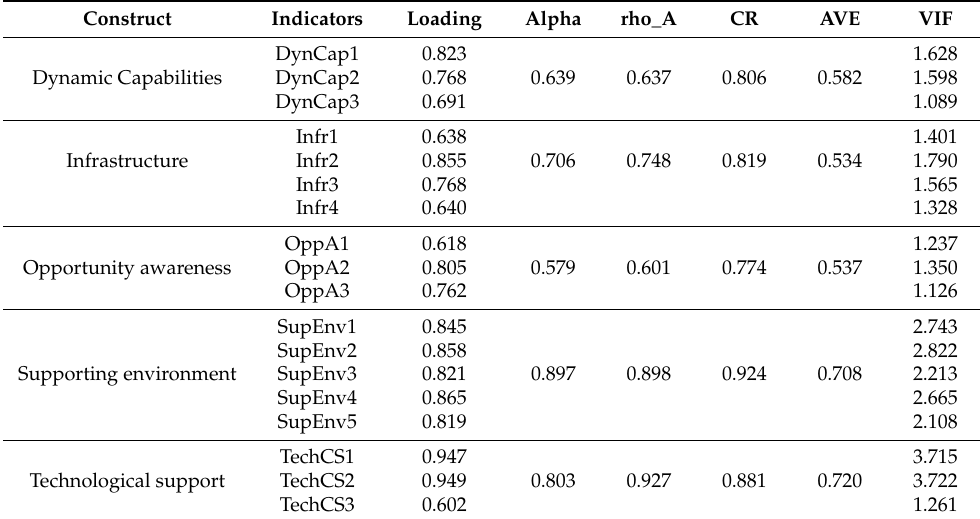
Table 3. Measurement specifications of outer